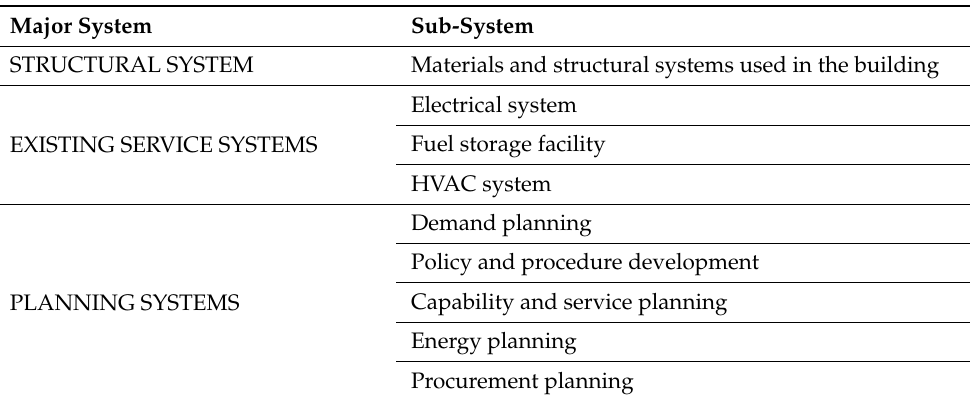
Table 1. Healthcare energy systems impacted by climate change (Derived from Ref. [31] Tonmoy, Fahim, Jean Palutikof, Sarah Boulter, Peter Schneider, and Sue Cooke. “Climate Change Adaptation